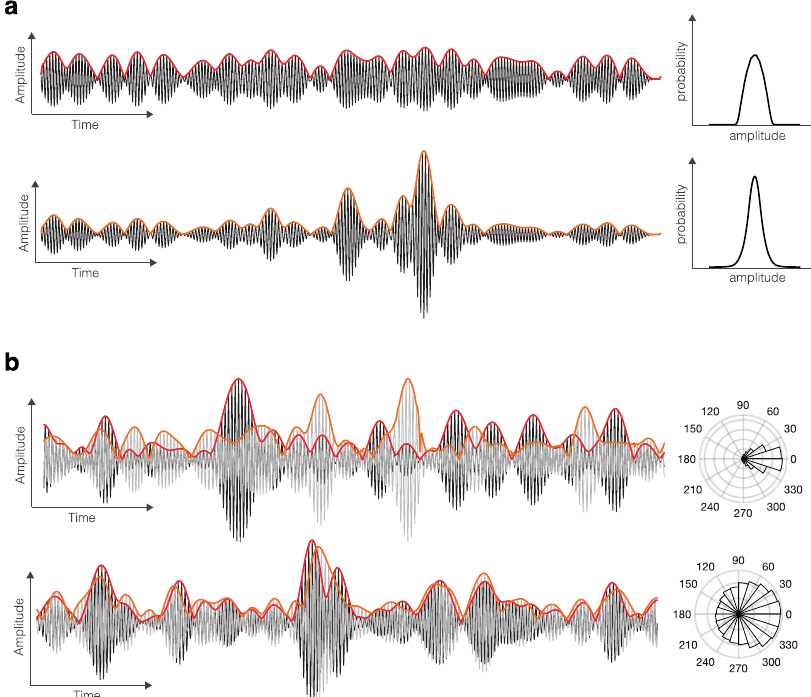
Fig. 1 Illustration of co)kurtosis of cortical signals. a Shown are two simulated cortical signals (black traces), together with their amplitude envelopes (red and orange traces) and distributions. The top and bottom signals have negative and positive kurtosis, respectively. Negative kurtosis (sub-Gaussiannity) is re fl ected in the absence of large amplitude fl uctuations and in “ thin tails ” of the distribution. Positive kurtosis (super-gaussiannity) is re fl ected in the presence of large amplitude fl uctuations and in “ fat tails ” of the distribution. b Top: Shown are two simulated super-Gaussian cortical signals (black and grey traces), together with their amplitude envelopes (red and orange traces, resp.) and the distribution of the difference between their instantaneous phases. The magnitude squared coherence is larger than the correlation between their power envelopes, corresponding to a negative cokurtosis. Bottom: Same format, but the magnitude squared coherence is smaller than the power correlation, corresponding to a positive